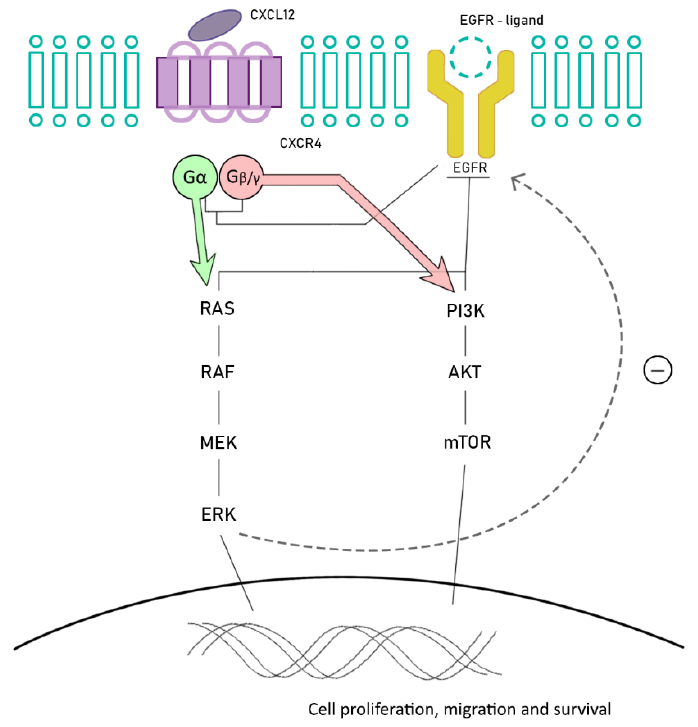
Figure 2. Chemokine (C-X-C motif) receptor 4 (CXCR4) / EGFR pathways crosstalk. CXCR4 is able to upregulate EGFR activation and finally ERK phosphorylation.